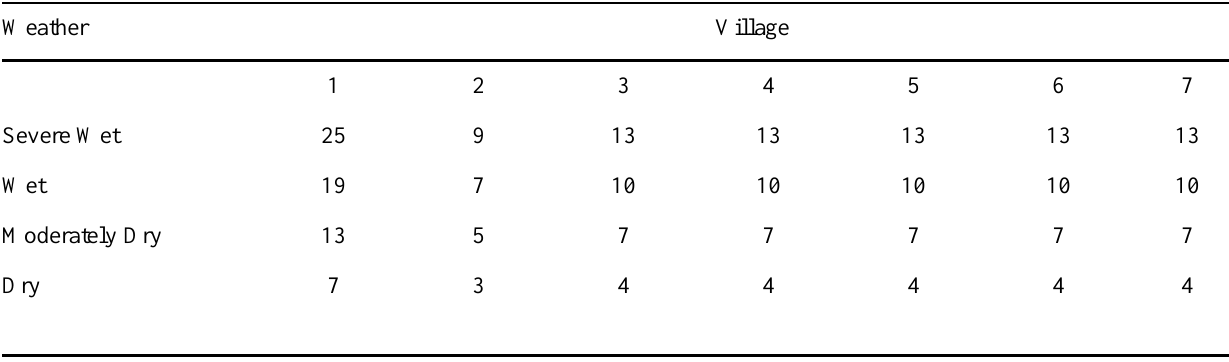
Table 8. Water share per village